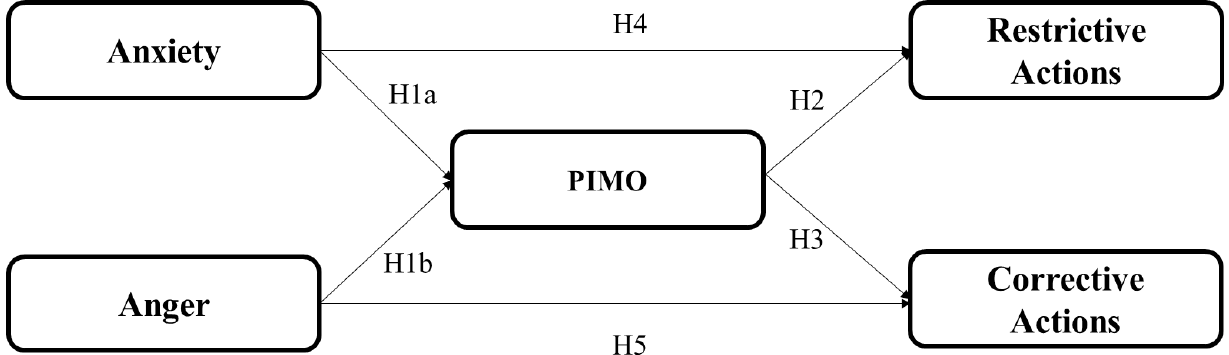
Figure 1. The Conceptual Framework. Note: PIMO = Presumed influence of misinformation on others.